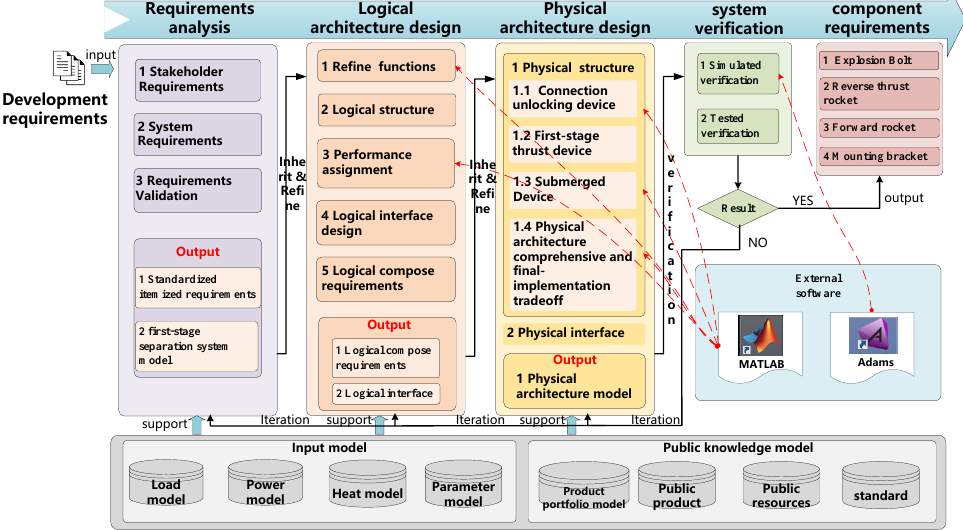
Figure 1. M odel framework of the separation system. Figure 1. Model framework of the separation